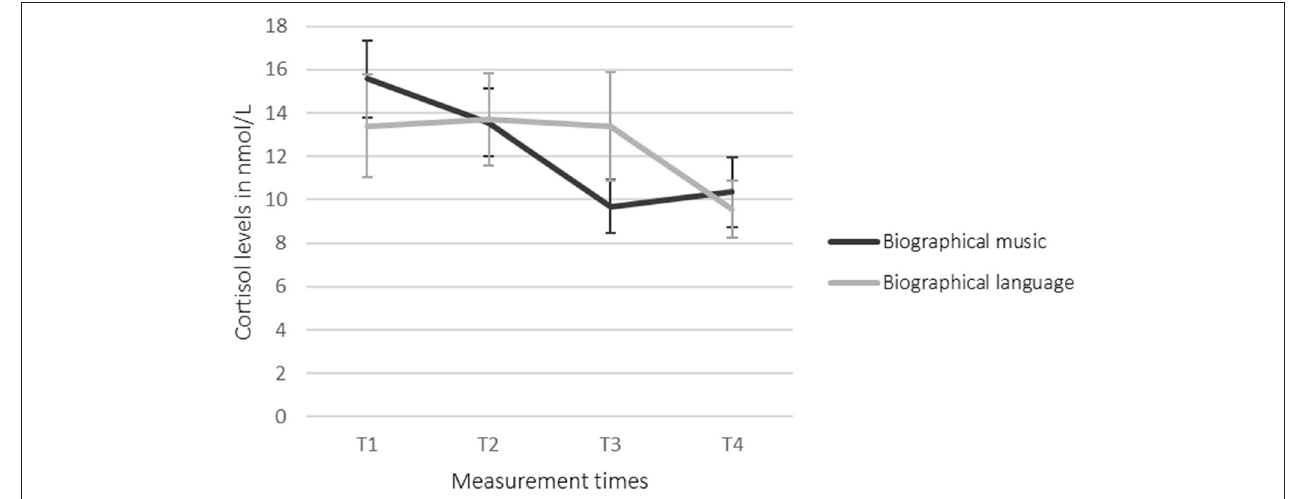
FIGURE 2 | Change in cortisol levels. Error bars represent the standard error of the mean (SEM).